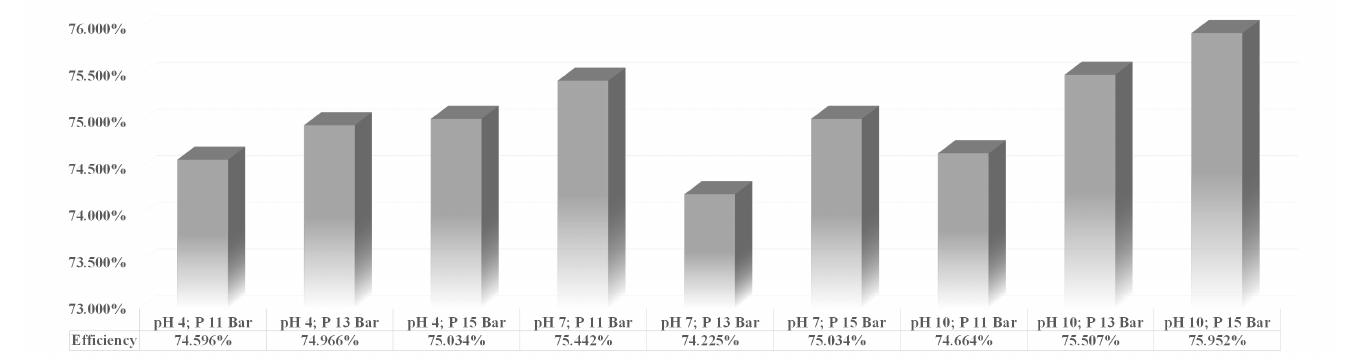
Figure 5. Efficiency of lithium recovery at various operating